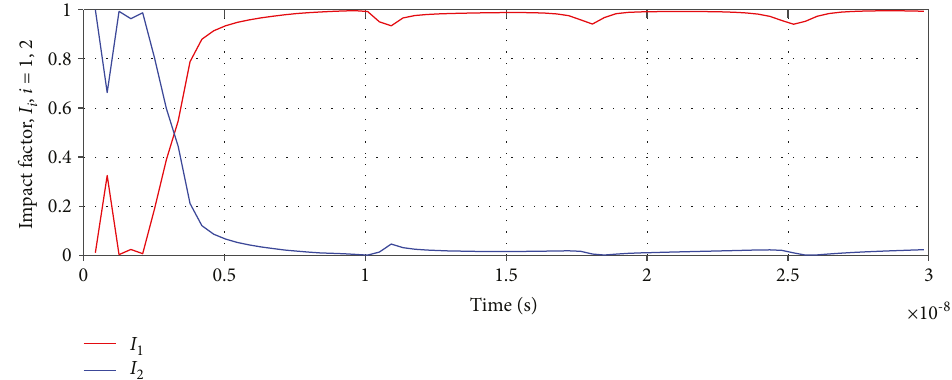
fl uence of the antenna length and I 1 represents the in